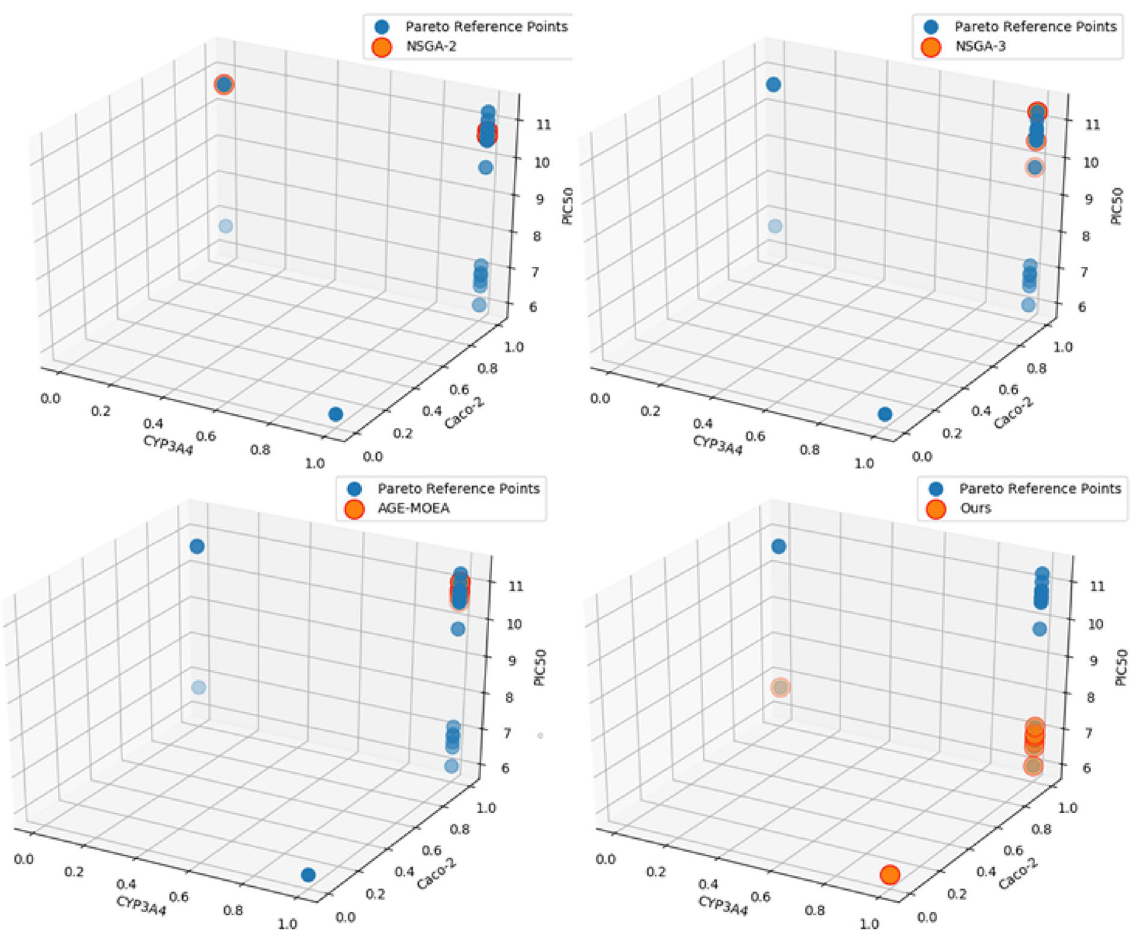
Figure 4. Visualization of solution